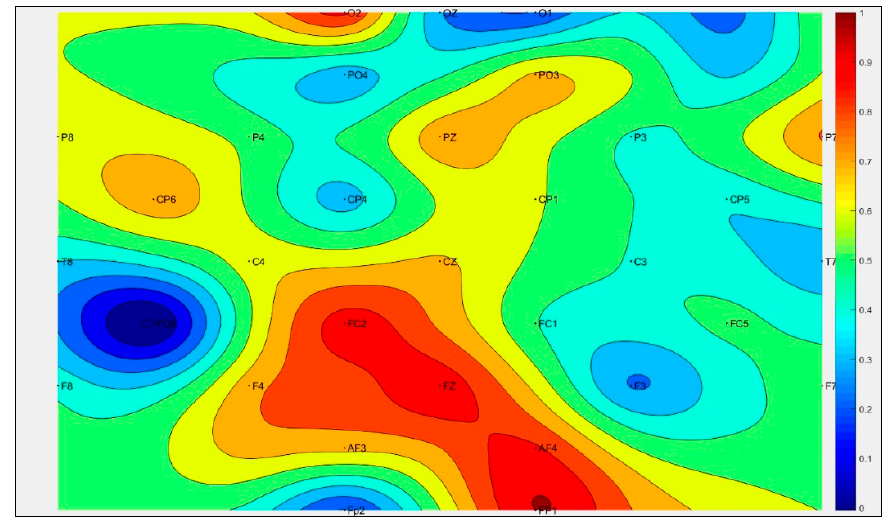
Figure 3. An enlarged EEG MFI with the names of the electrodes and contour lines.